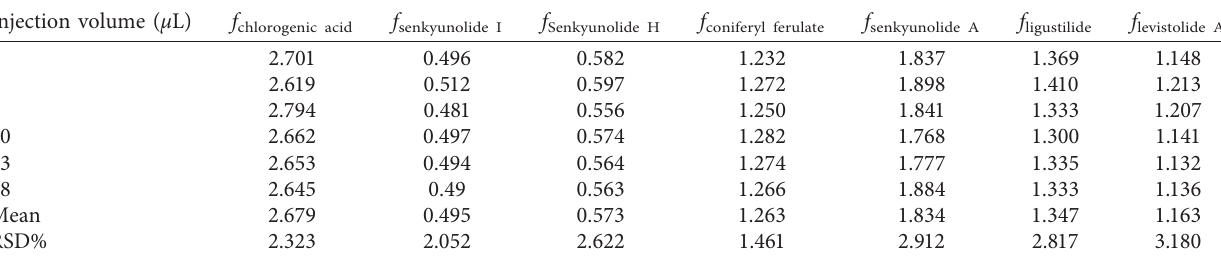
Table 2: Results of RCF of 7 components in ASR.